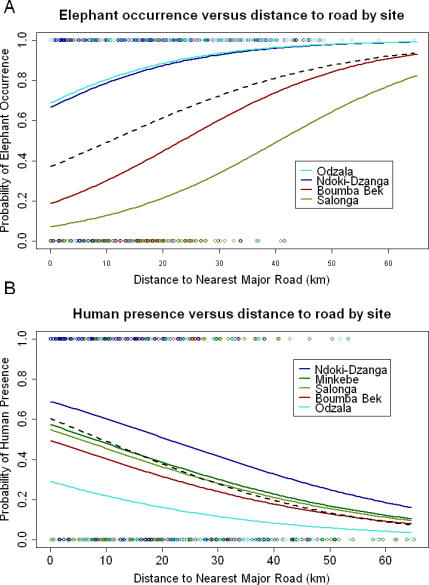
Results of Fitting a Logistic Regression Model to Elephant and Human Presence/Absence Data Pooled across MIKE Survey SitesDistance to road (in kilometres) and site were used as explanatory variables. (A) shows the elephant data, and (B) shows the human data. The observations and regression lines are colour-coded by site and the dashed line shows the regression line without the inclusion of site as a covariate. The covariates distance to road and site are significant for both elephant and human probability of occurrence. The dissimilarity between sites is more pronounced when modelling the probability of elephant occurrence.